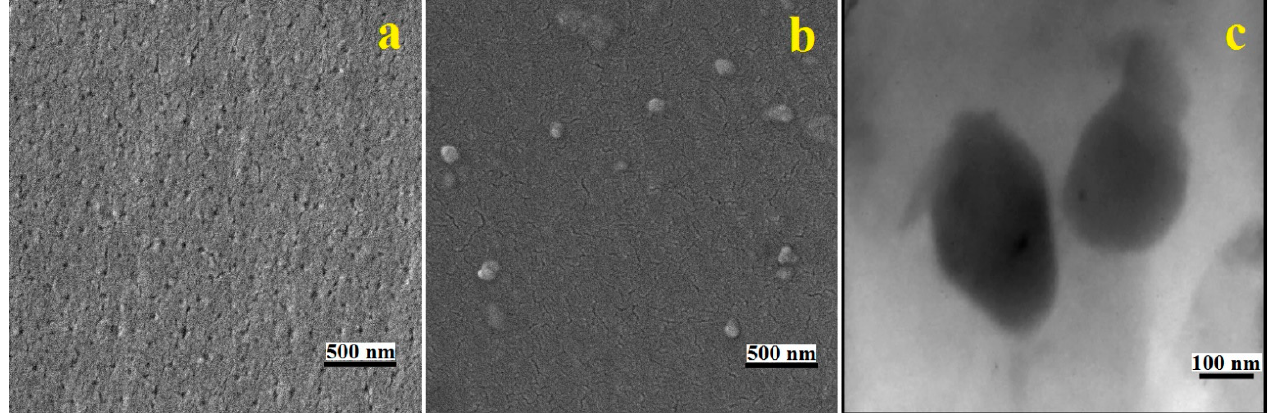
Figure 3. SEM images of ( a ) neat epoxy resin and ( b ) epoxy resin/1% UFNBRP, and TEM image of ( c ) epoxy resin/1% UFNBRP.